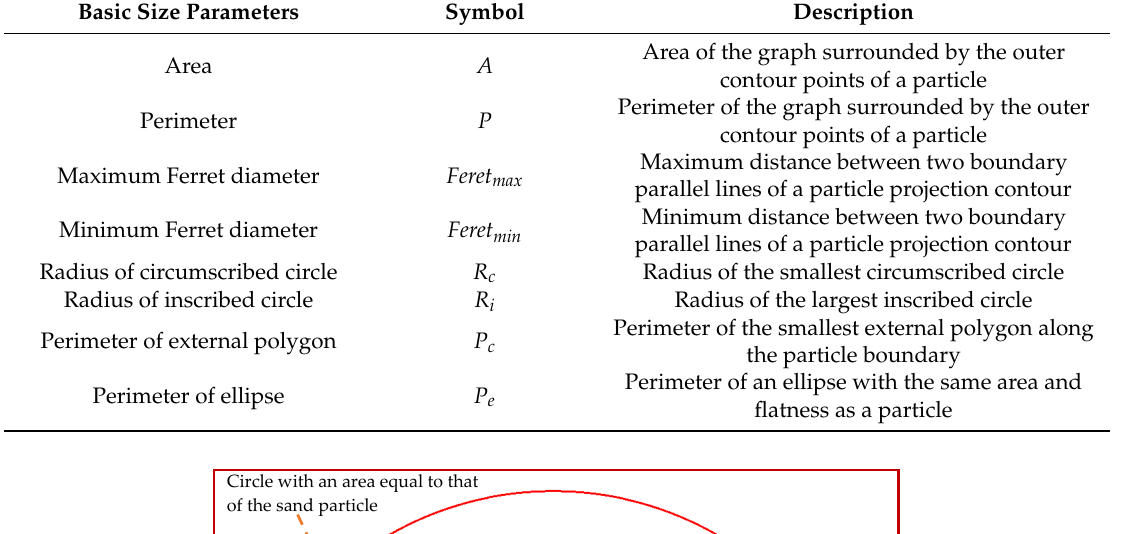
Table 2. Basic size parameters of the particle.